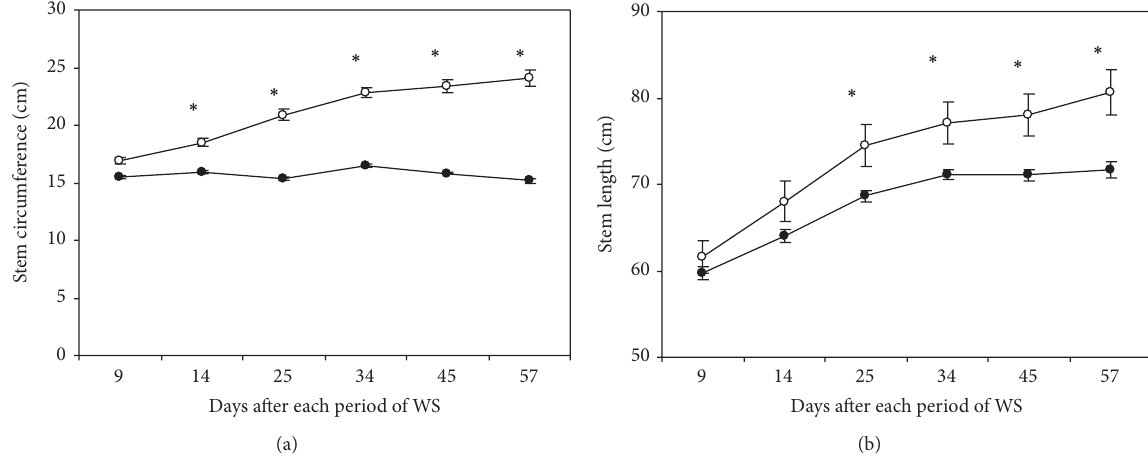
Figure 4: Pseudostem circumference (a) and length (b) determined in regularly irrigated ( I ) and water-stressed ( e ) banana plants. Data are means ± SE and each value was determined in three different plants with three replicates per treatment ( 𝑛 = 9 ). Data were compared for each date using the least significant difference (LSD) test. Significant differences at 𝑃 ≤ 0.05 are represented by an asterisk ( ∗ ). WS: water